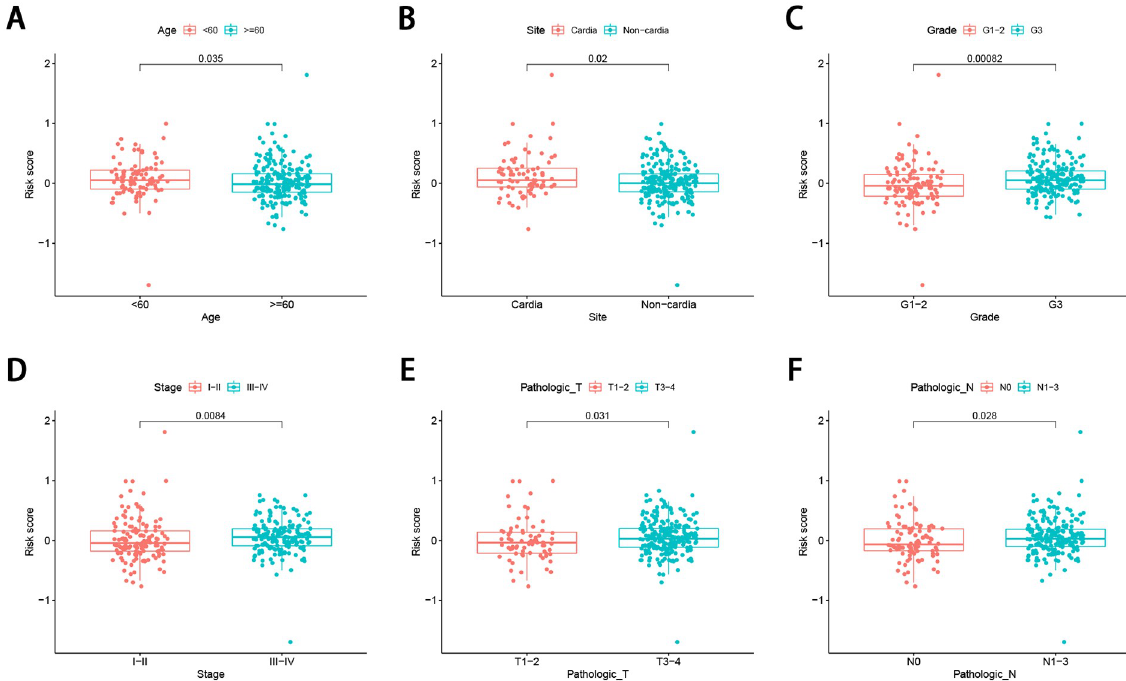
Fig 4. Association between the FRG signature and the clinicopathological characteristics (A) age (B) tumor site (C) grade (D) tumor stage (E) T stage (F) N stage.